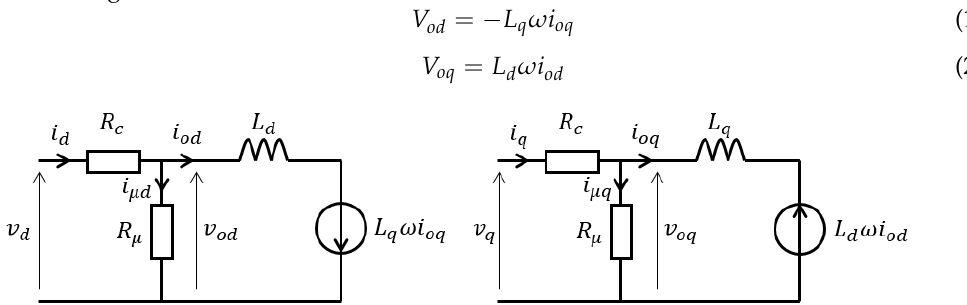
Figure 2. d ‐ q axis equivalents circuits. Figure 2. d-q axis equivalents